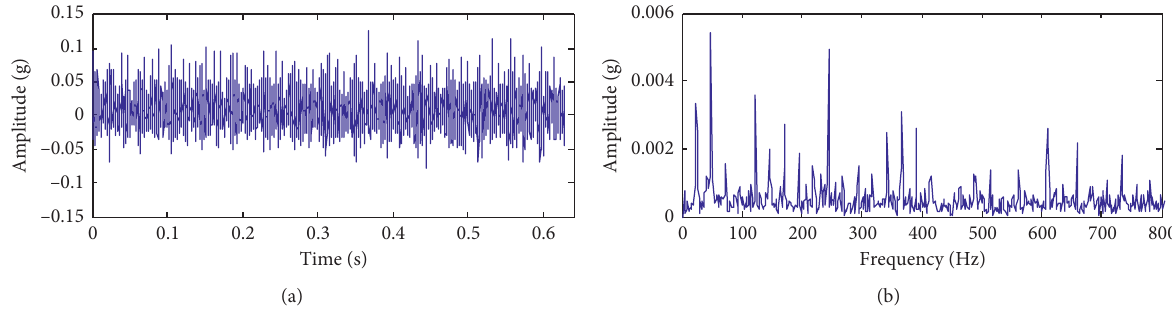
Figure 16: Comparison results of experimental signal by the MOMEDA method: (a) the waveform of deconvolution signal; (b) the envelope spectrum of deconvolution